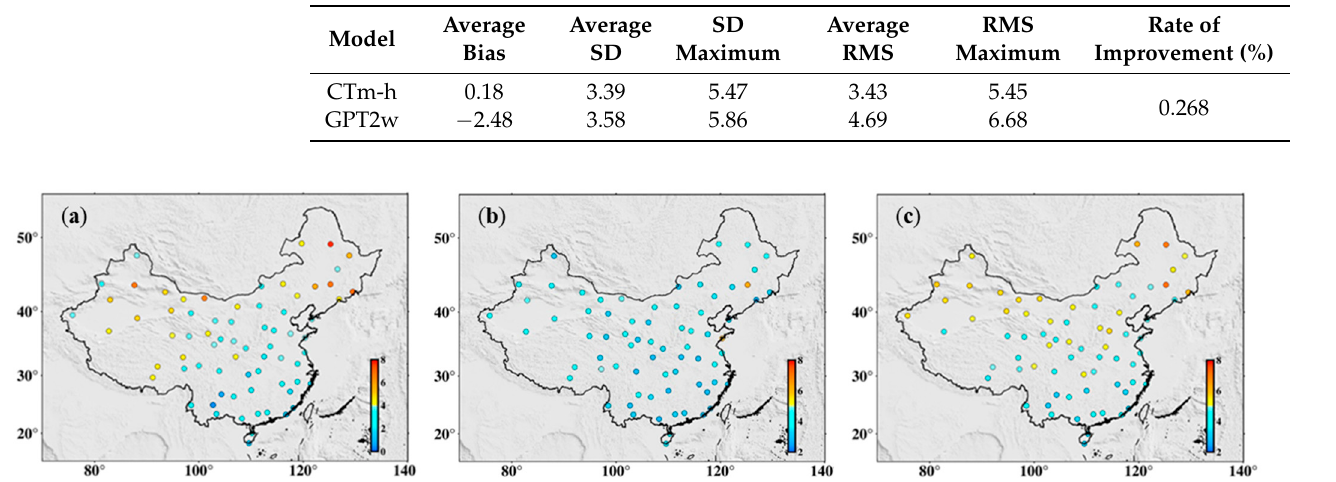
Table 2. Precision statistics of CTm-h and GPT2w models (K).